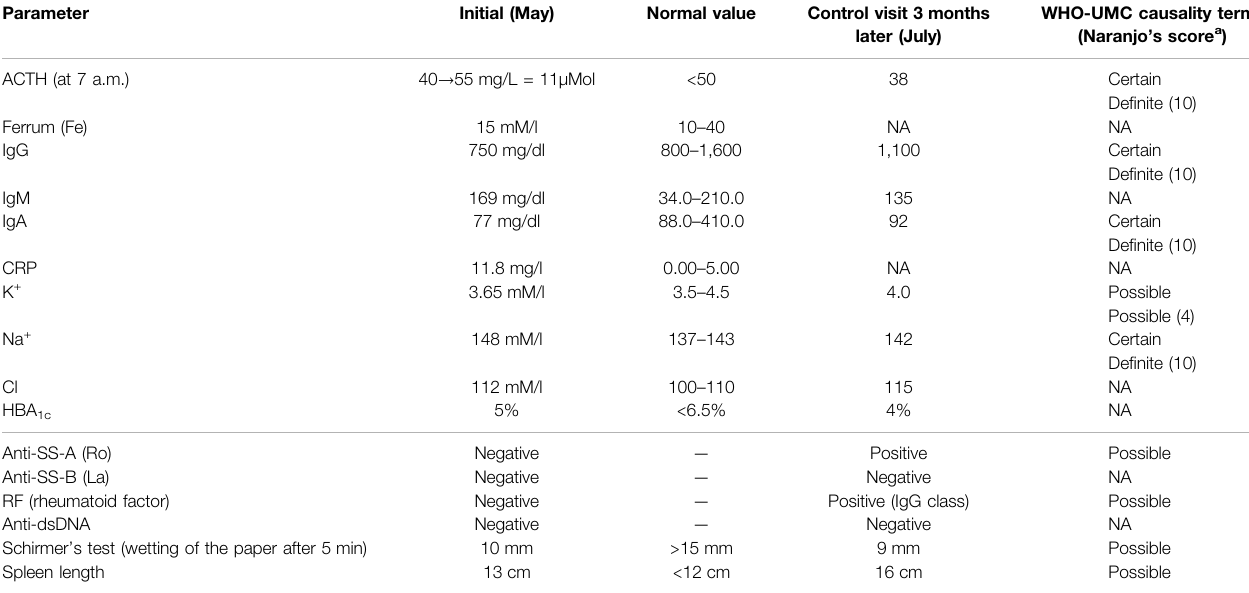
WHO-UMC causality term b later (July) (Naranjo ’ s score a )